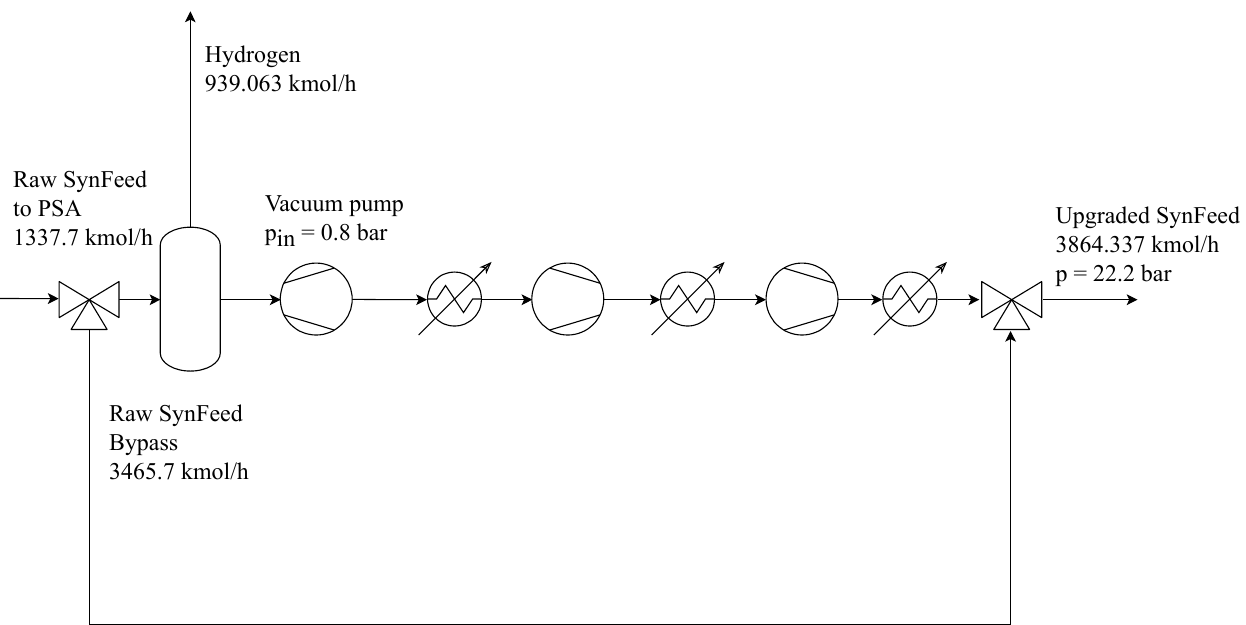
Figure A3. Process flow diagram of hydrogen removal PSA train.